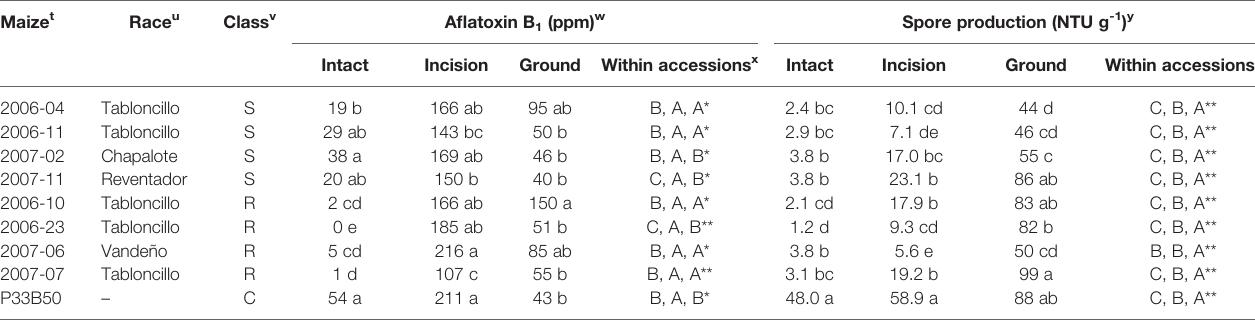
TABLE 1 | A fl atoxin B 1 and spore production by Aspergillus fl avus AF13 in kernels of resistant and susceptible maize landrace accessions, four of each, and commercial hybrid P33B50 that were either intact, with an incision, or ground. Maize t